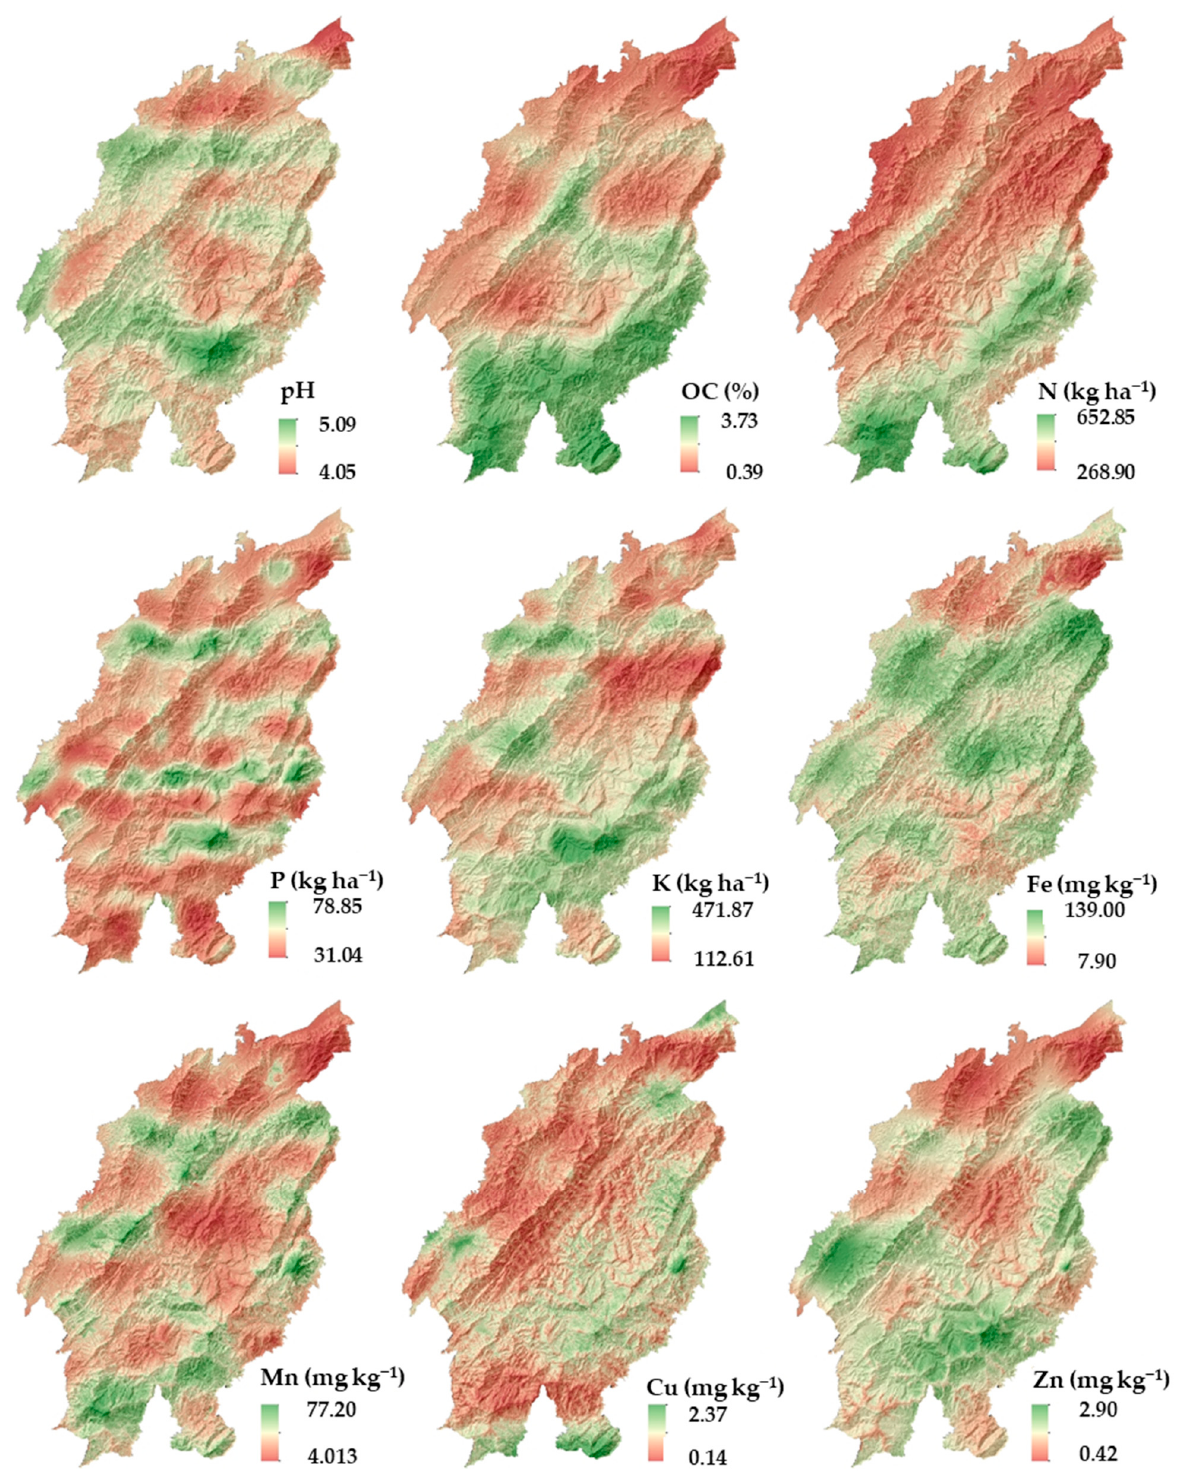
Figure 5. Predicted soil properties map in India’s north-eastern Himalayan area. pH; OC, soil organic carbon; N, available nitrogen; P, available phosphorus; K, available potassium; Fe, Mn, Cu and Zn represent DTPA-extractable iron, manganese, copper and zinc in soil, respectively.